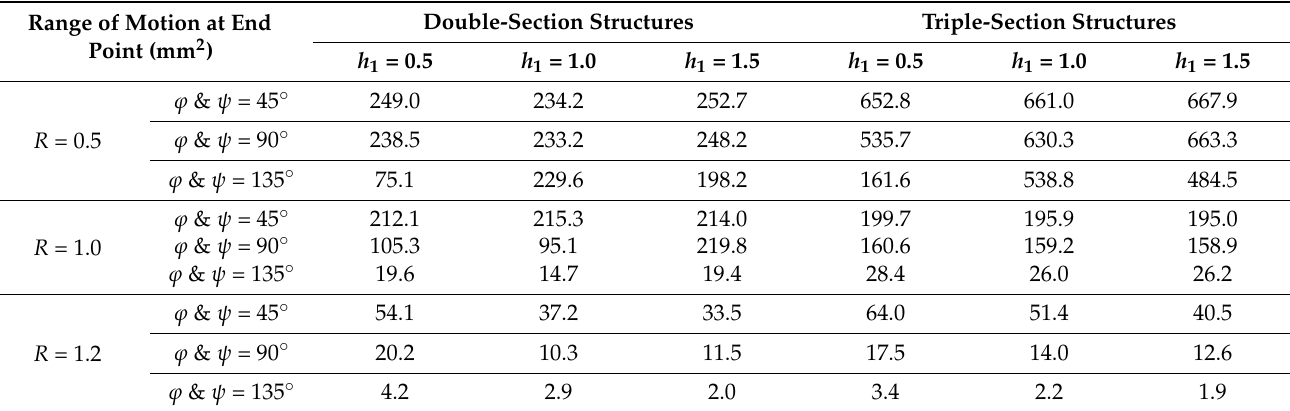
Table 1. Range of motion for different linkage parameters.